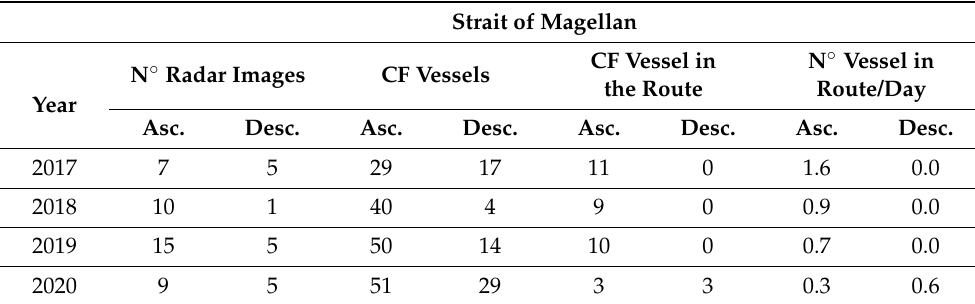
Table 3. Summary of the vessel detection analysis using the object-oriented algorithm and SAR Sentinel-1 data for the Strait of Magellan (ascending, Asc.; descending, Desc.). CF: Cumulative frequency. Strait of